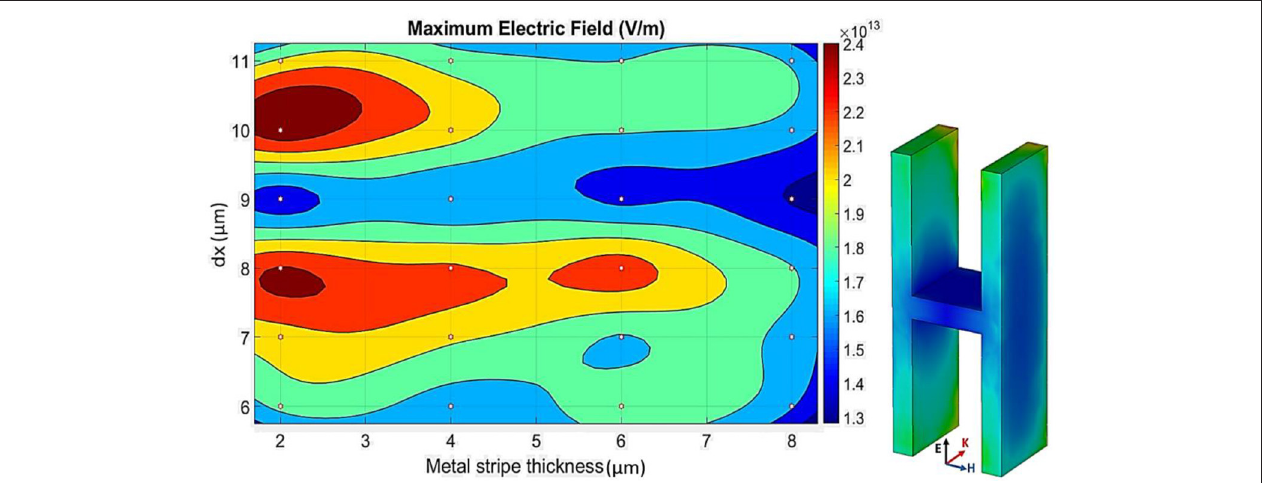
FIGURE 5 | Maximum electric field of the structure. This parameter is an indicator of the field confinement in the metal stripe. A fitting tool is applied to estimate the best physical dimensions for the highest possible electric field. Therefore, for 24 different combinations of metal thickness and d x (red stars), the electric field is calculated, and then, using a biharmonic fitting function, a 2-D contour plot is generated. According to the plot, the highest electric field confinement can be achieved at metal stripe thickness = 2 µ m and d x = 8, 10 µ m.